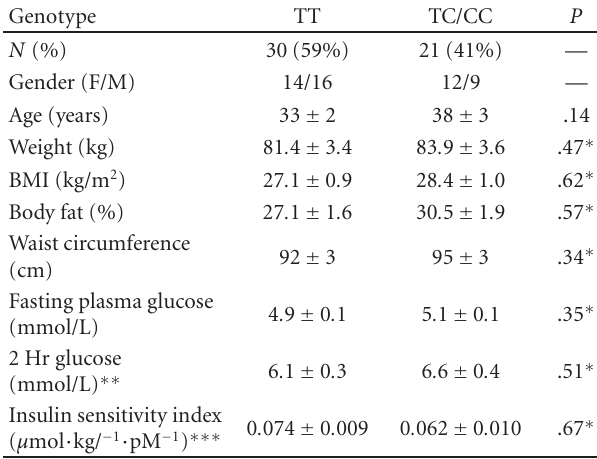
Table 1: Subject characteristics and e ff ect of rs17782313 on obesity measures and peripheral insulin